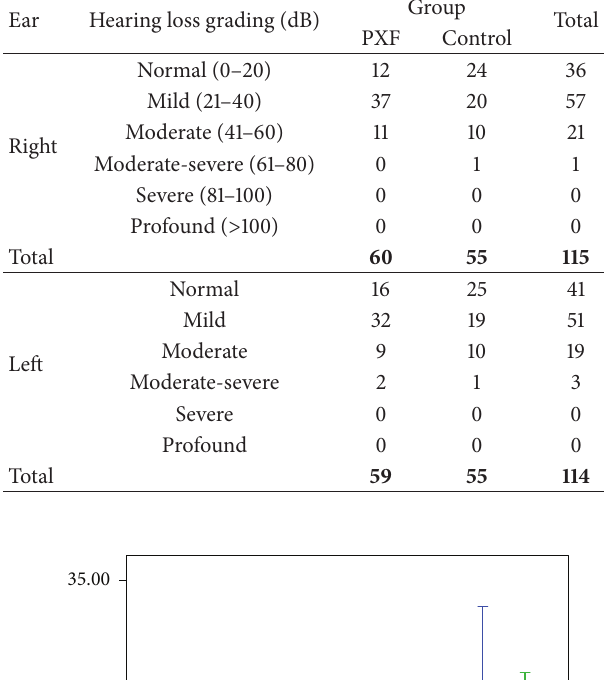
Table 2: Hearing loss graded according to severity in both ears.